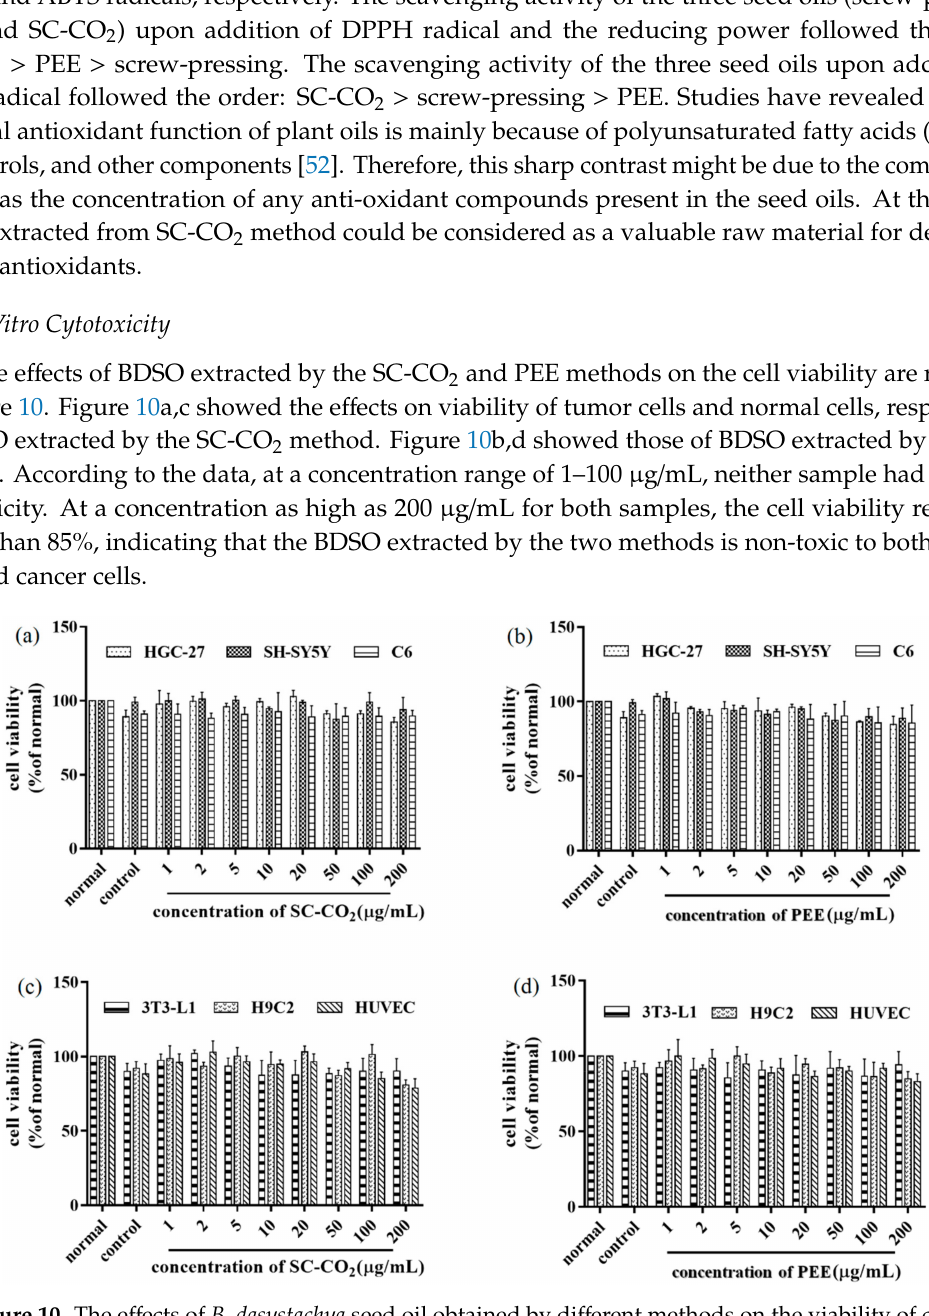
Figure 10. The e ff ects of B. dasystachya seed oil obtained by di ff erent methods on the viability of cells in vitro. ( a ) Oil extracted using SC-CO 2 on tumor cells; ( b ) Oil extracted using PEE on tumor cells; ( c ) Oil extracted using SC-CO 2 on normal cells; ( d ) Oil extracted using PEE on normal cells. Data are given as means ± SD ( n =